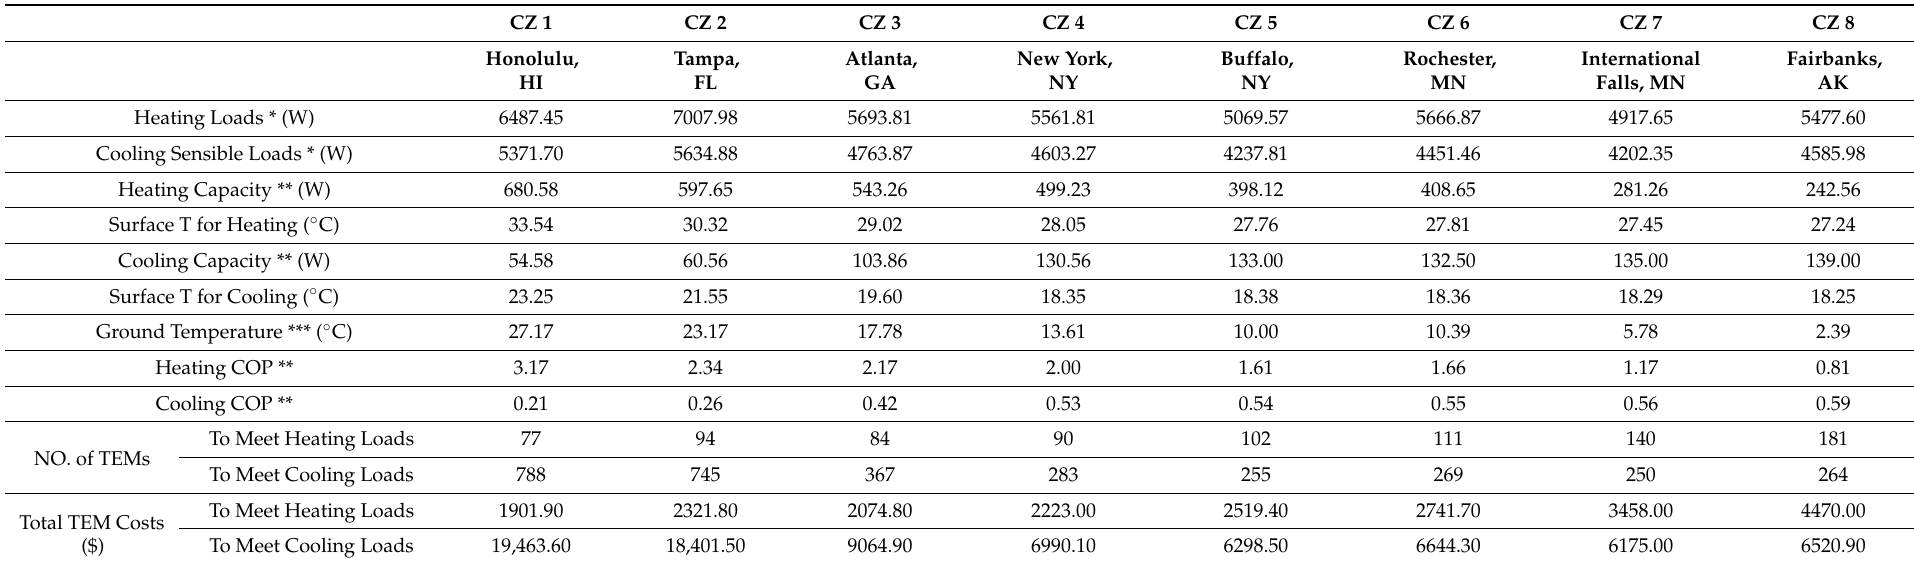
Table 3. System performance for a single-family